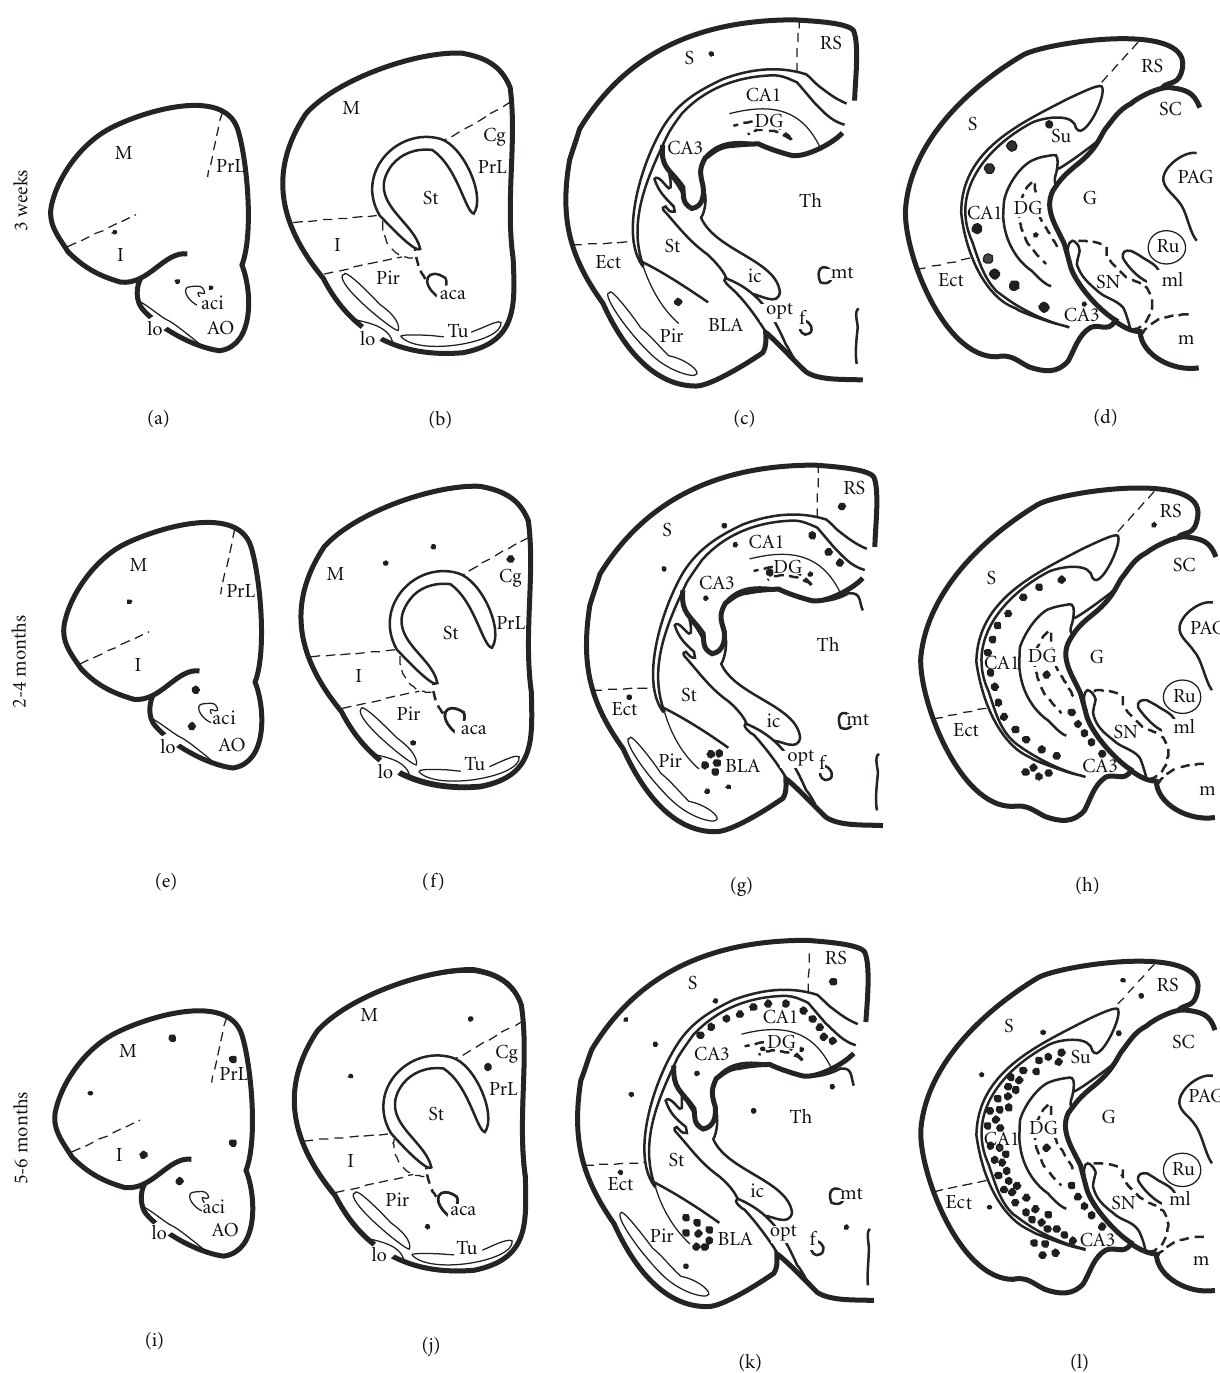
Figure 4: Schematic drawings showing the distribution of Alz50-ir neurons at 3-week, 2-, and 5-month-old transcardially-fixed 3xTg-AD mice. Alz50-ir neurons were found mainly in the CA1 ventral hippocampus at 3 weeks of age. Note the increase in the number of Alz50-ir hippocampal neurons in the 2- and 5-month old mutant mice. In addition there was an age-related increase in Alz-50 positive neurons within the BLA. Abbreviations are the same as in Figure 2. Small dots = 1–5 positive neurons, medium-size dots = 10–20 positive neurons, and large dots = 100 positive